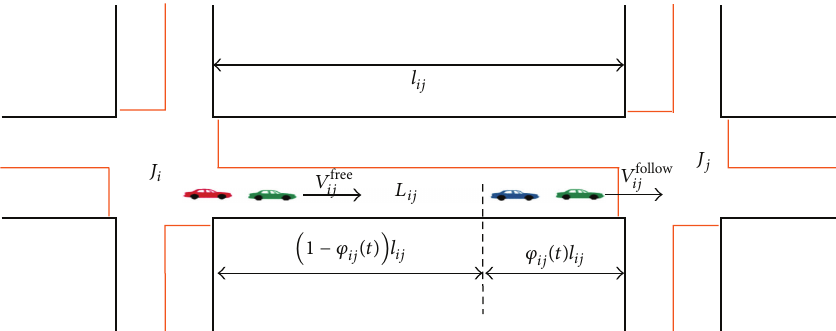
Figure 5: The traffic flow relationship of the adjacent signalized intersection with optimum signal